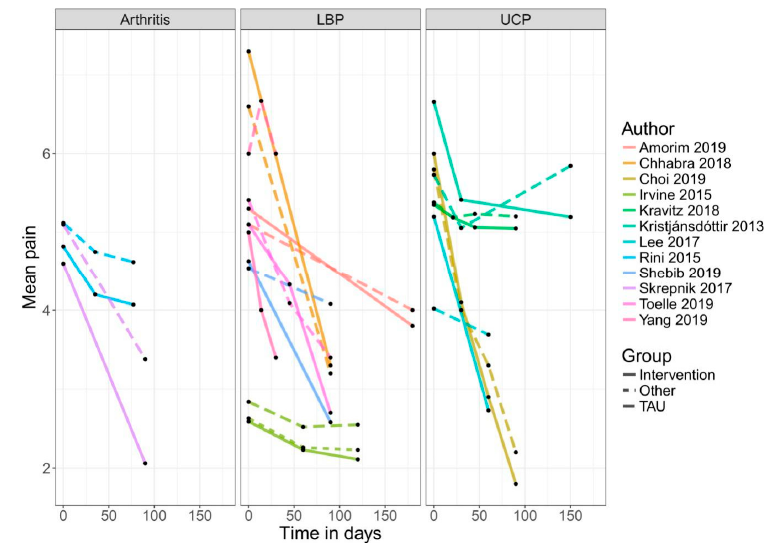
Figure3. ImprovementinpainovertimeinRCTs. Abbreviations: LBP = lowbackpain; UCP = unspecific Figure 3. Improvement in pain over time in RCTs. Abbreviations: LBP = low back pain; UCP = chronic pain; TAU = treatment as usual. J. Clin. Med. 2020 , 9 , x FOR PEER REVIEW 13 of 20 unspecific chronic pain; TAU = treatment as usual.